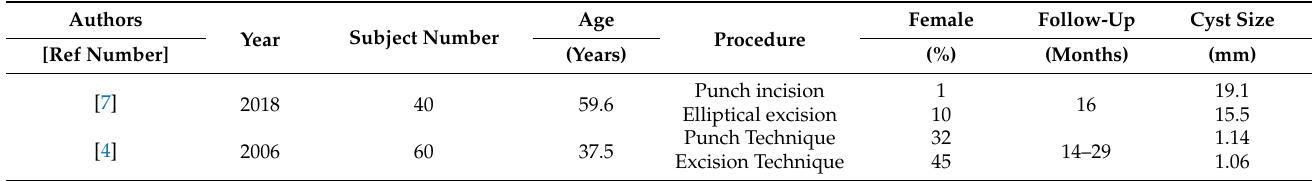
Table 1. Summary of the characteristics of the eligibility